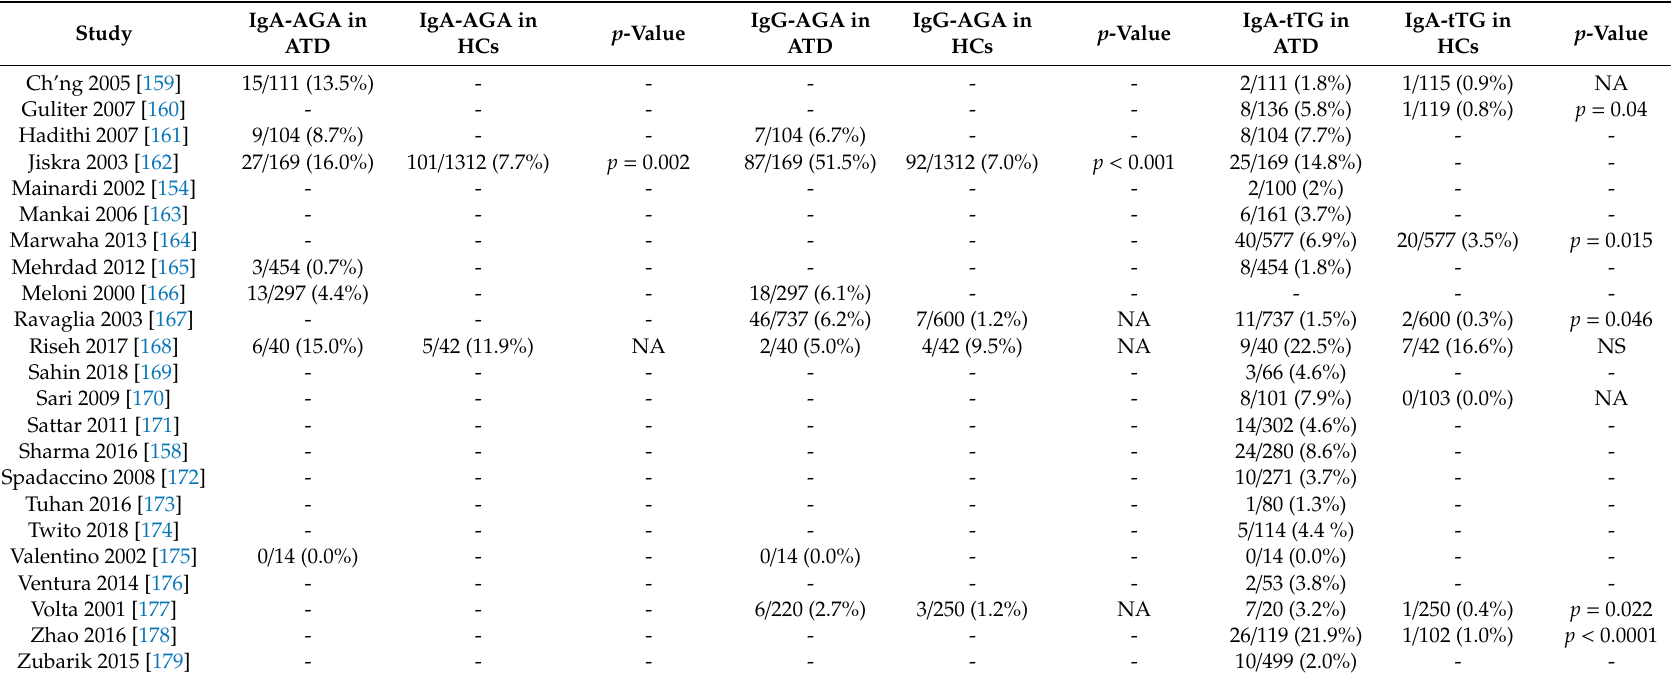
Table 3. Case–control and cross-sectional cohort studies estimating the prevalence of IgA-AGA and IgG-AGA in patients with ATD and HCs. Results are presented as “number of seropositive individuals” / “number of individuals tested” (%). AGA: antigliadin antibody, ATD: autoimmune thyroid disease, HCs: healthy controls, Ig: immunoglobulin, NA: not